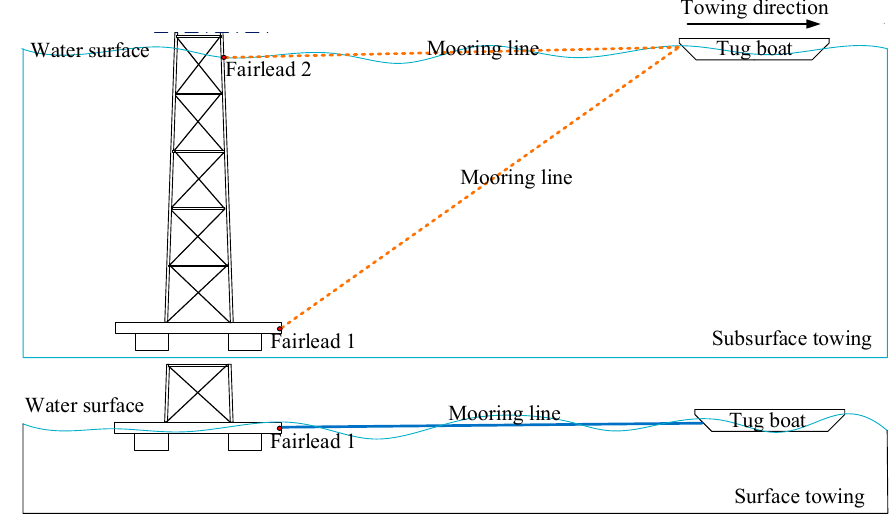
Figure 2. Surface towing and submerged towing methods.